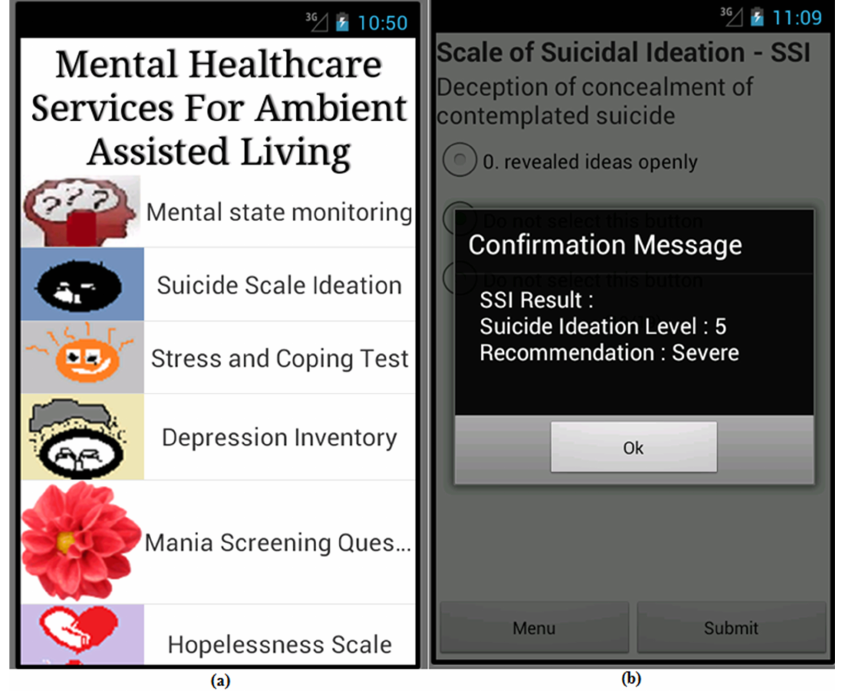
Figure 11. The prototype implementation of AAL framework: ( a ) Enabled mental healthcare services